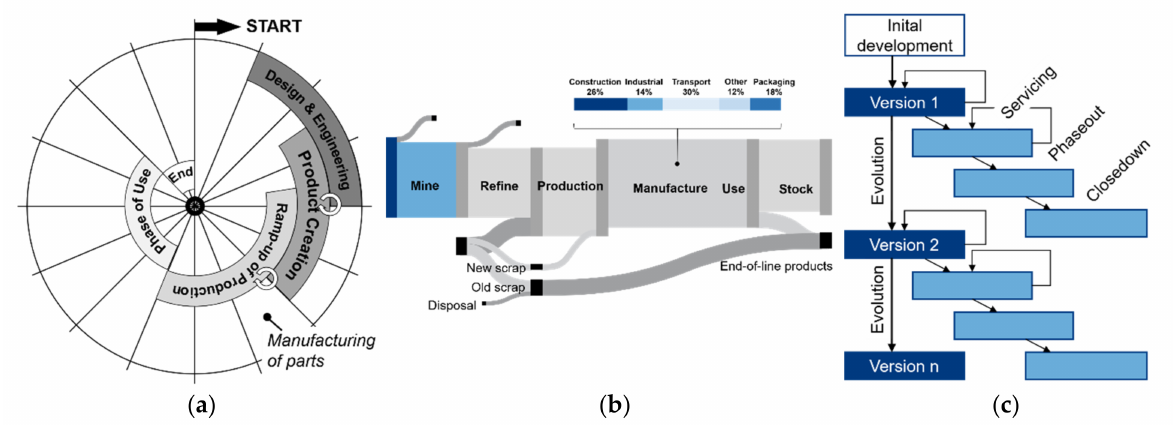
Figure 2. Specific perspectives of the product lifecycle: ( a ) intrinsic product lifecycle focusing on product development, production and use (based on [31]); ( b ) material lifecycle emphasizing volumes of material use in product lifecycle phases (see [36]); ( c ) software lifecycle illustration focusing on continuous evolution and resulting branches (based on